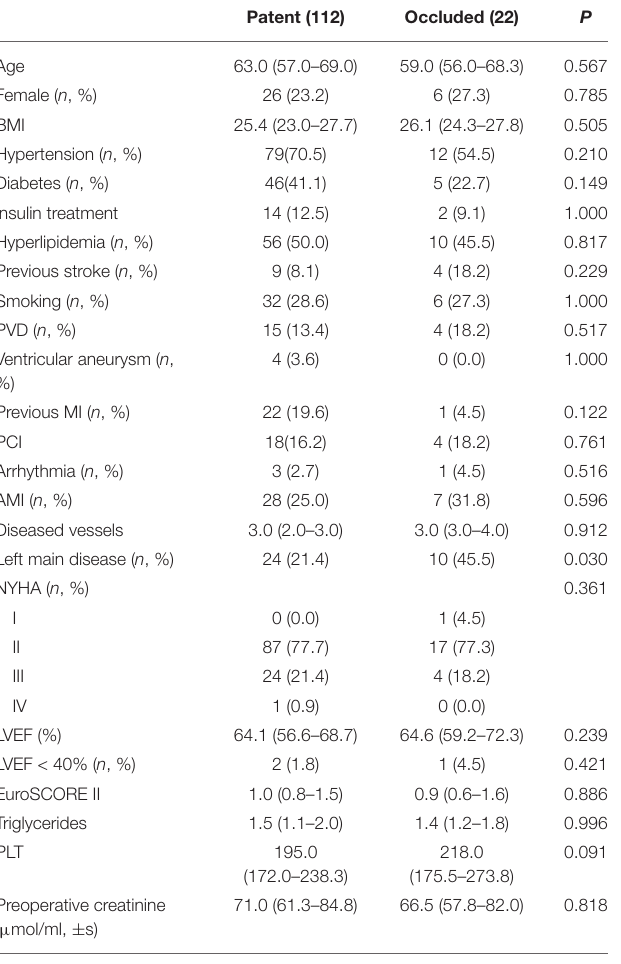
TABLE 1 | Baseline patient characteristics of the patent group and the occluded group.